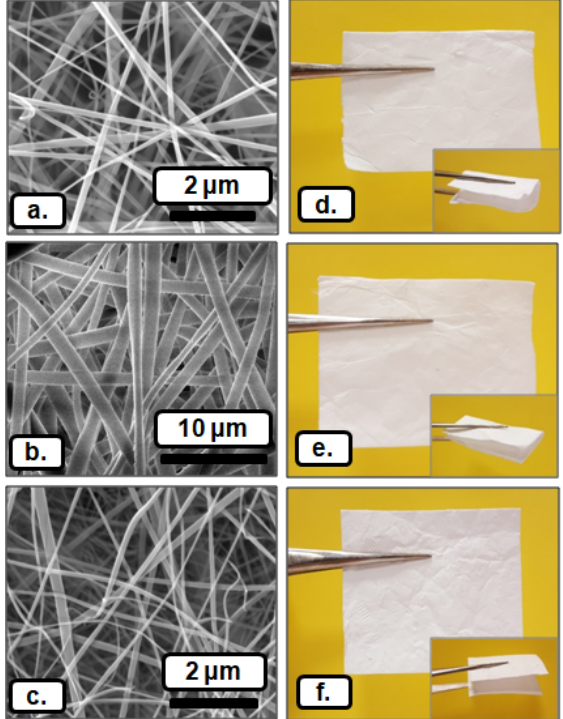
Figure 3. Scanning electron microscopy (SEM) images of electrospun nanofibers of ( a ) citral/HPβCD- IC NF, ( b ) citral/HPγCD-IC NF, and ( c ) citral/MβCD-IC NF; the photographs of ( d ) citral/HPβCD-IC- NF, ( b ) citral/HP γ CD-IC NF, and ( c ) citral/M β CD-IC NF; the photographs of ( d ) citral/HP β CD-IC-NF, NF, ( e ) citral/HPγCD-IC-NF, and ( f ) citral/MβCD-IC-NF webs. ( e ) citral/HP γ CD-IC-NF, and ( f ) citral/M β CD-IC-NF